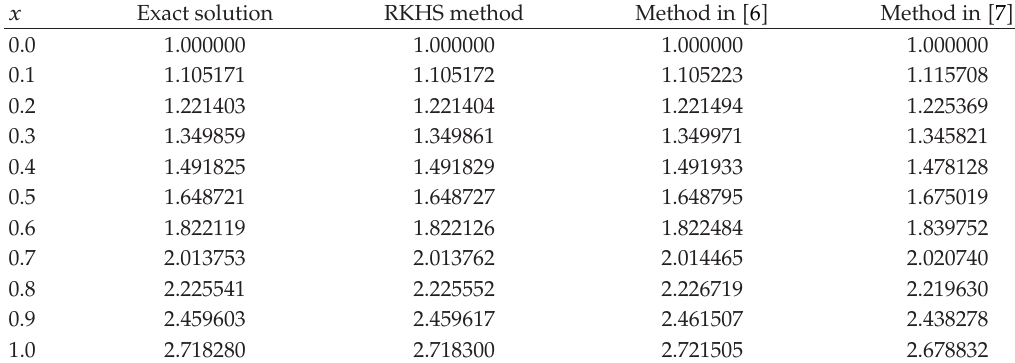
Table 5: Numerical comparison of approximate solution for Example 5.2.